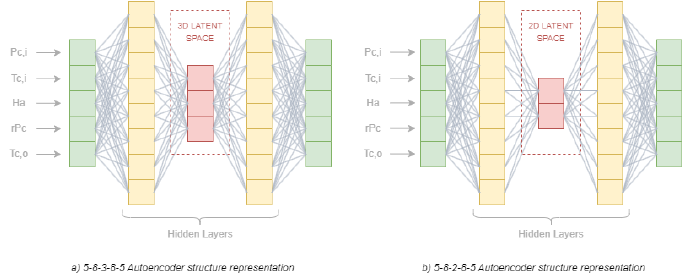
Figure 3. Representation of the two autoencoder structures employed to model a fresh gas turbine’s